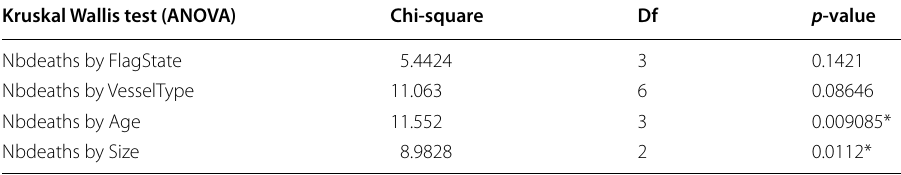
* significant p < 0.05